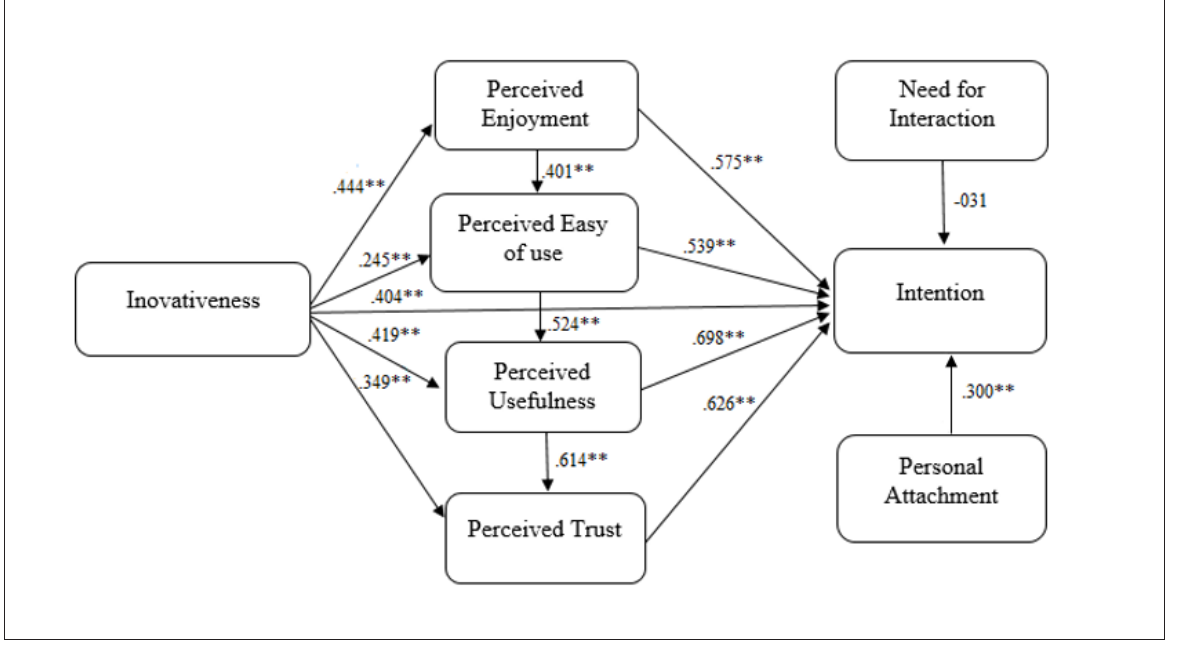
Figure. Correlations between user innovativeness, apps perception, personal attachment, and the need for interaction with intentions to use sports